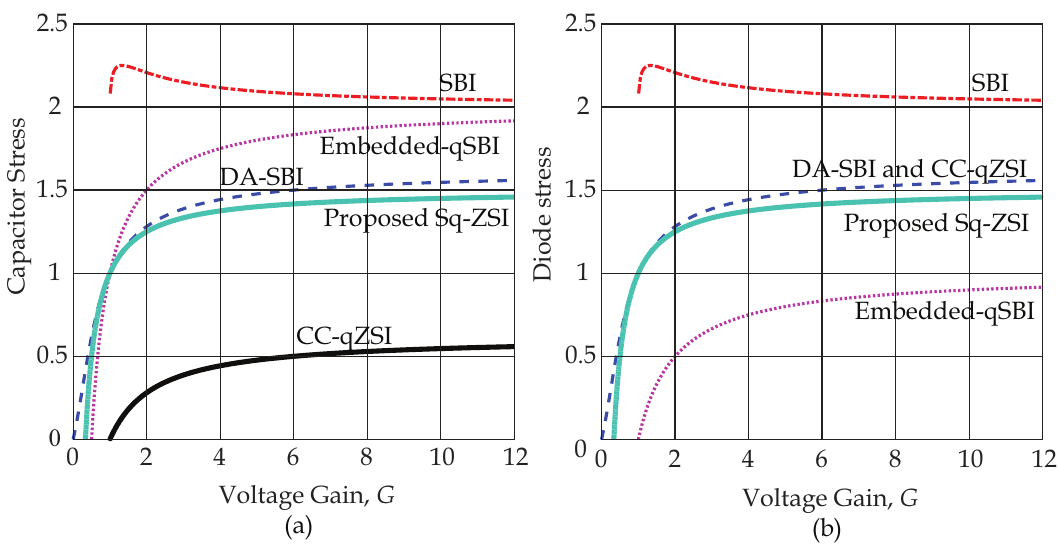
Figure 9. Stress comparison among the selected topologies with various voltage gains: ( a ) capacitor ( C 1 ) stress comparison, and ( b ) diode ( D 1 ) stress